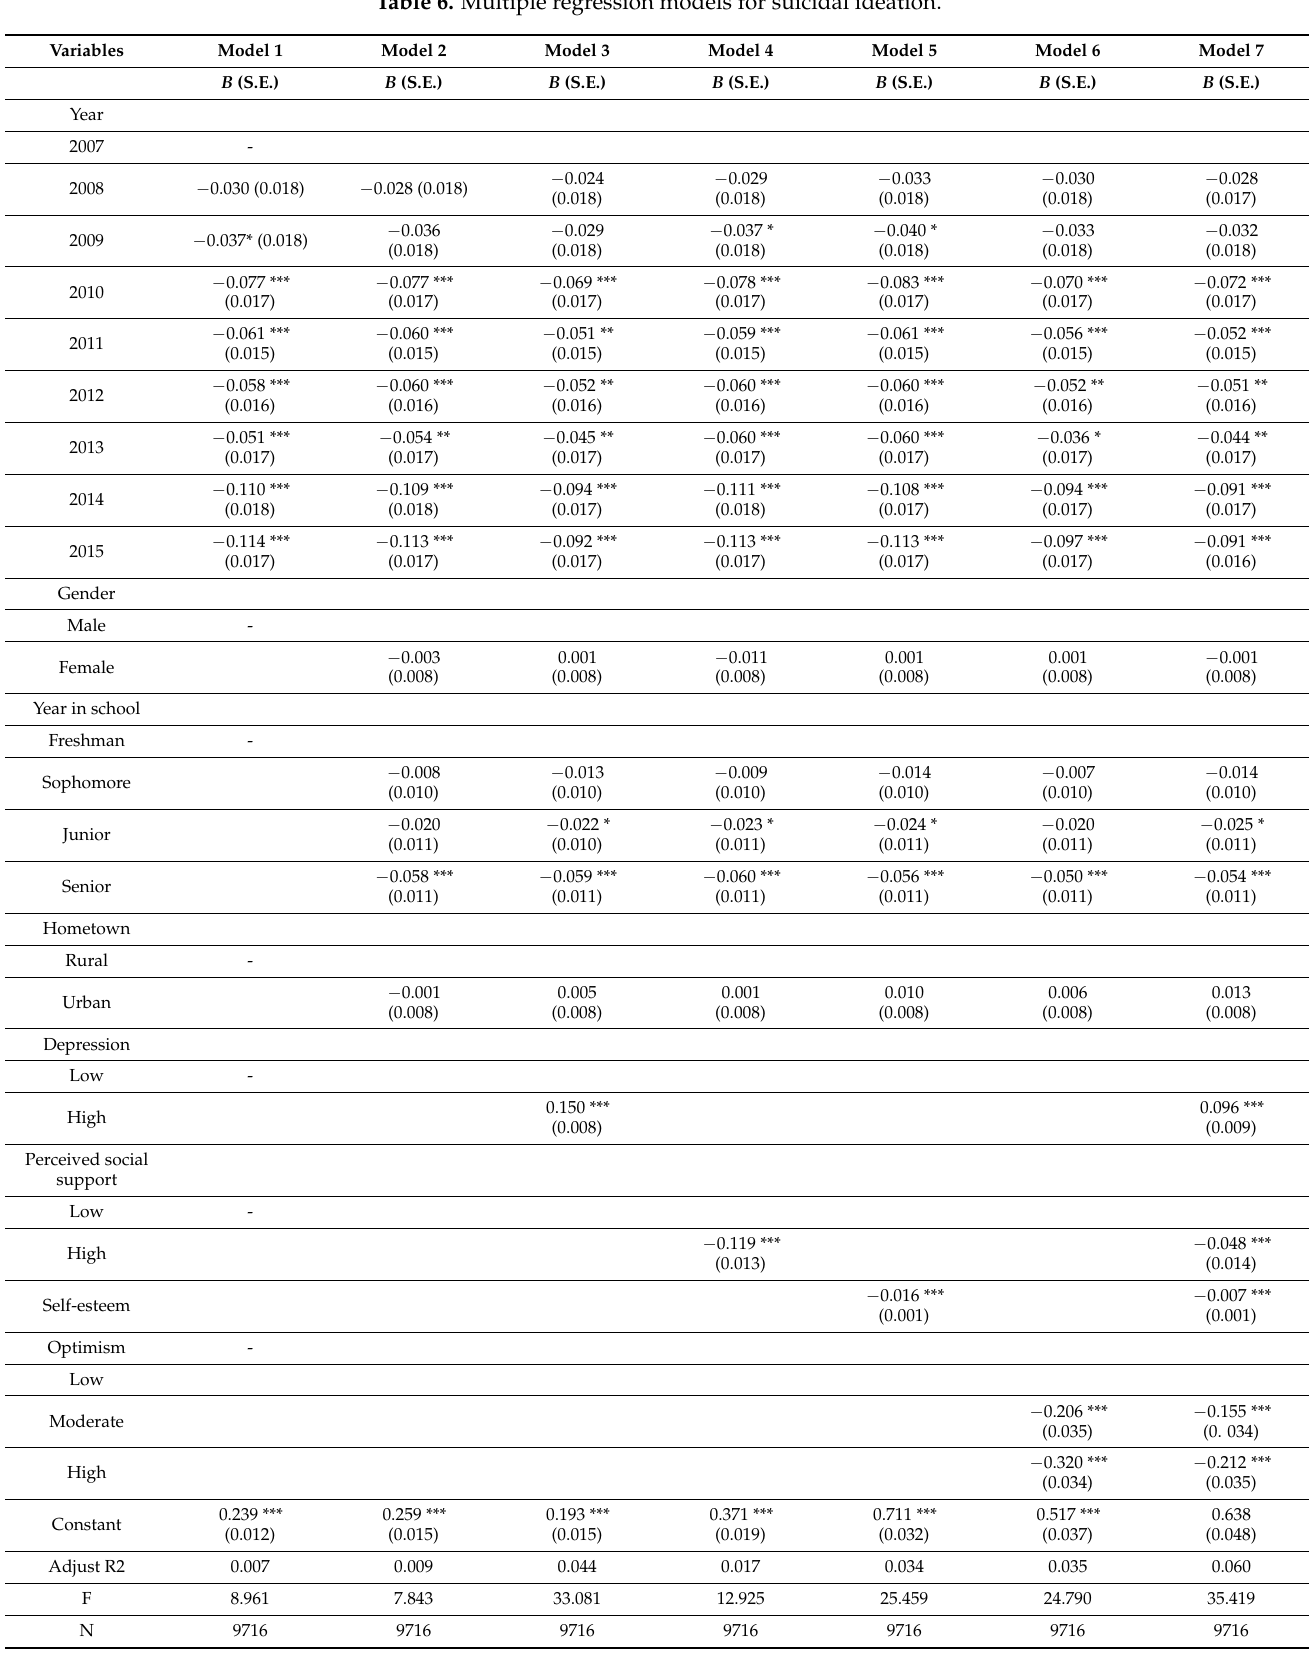
Table 6. Multiple regression models for suicidal